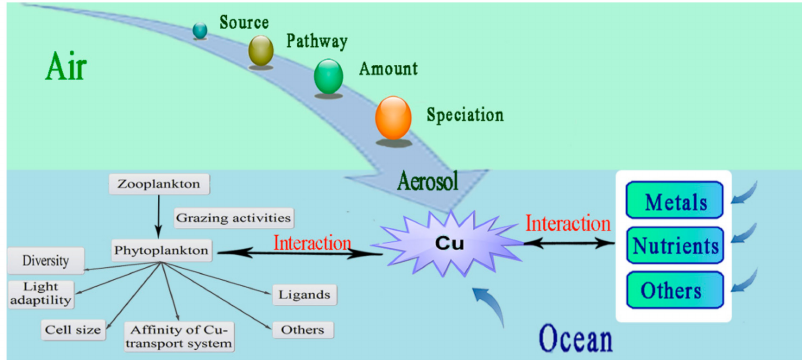
Figure 2. Factors a ff ecting the Cu toxicity for marine phytoplankton.